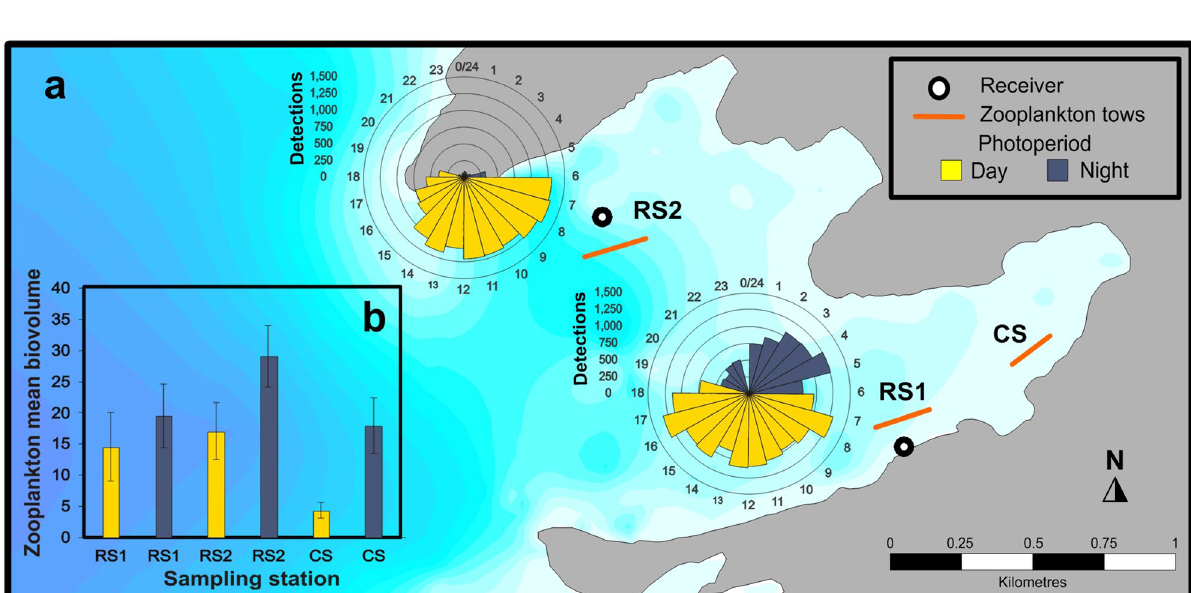
Figure 5. ( a ) Receiver locations (black–white dots: RS1 at 5 m depth and RS2 at 26 m depth) and zooplankton sampling stations (orange lines) locations at Ensenada Grande. Circular plots of detections per hour of acoustic tagged M. munkiana (n = 7) at each receiver. ( b ) Zooplankton mean biovolume (mL 100 m −3 ) and standard error at the three sampling stations collected at day and night during the study